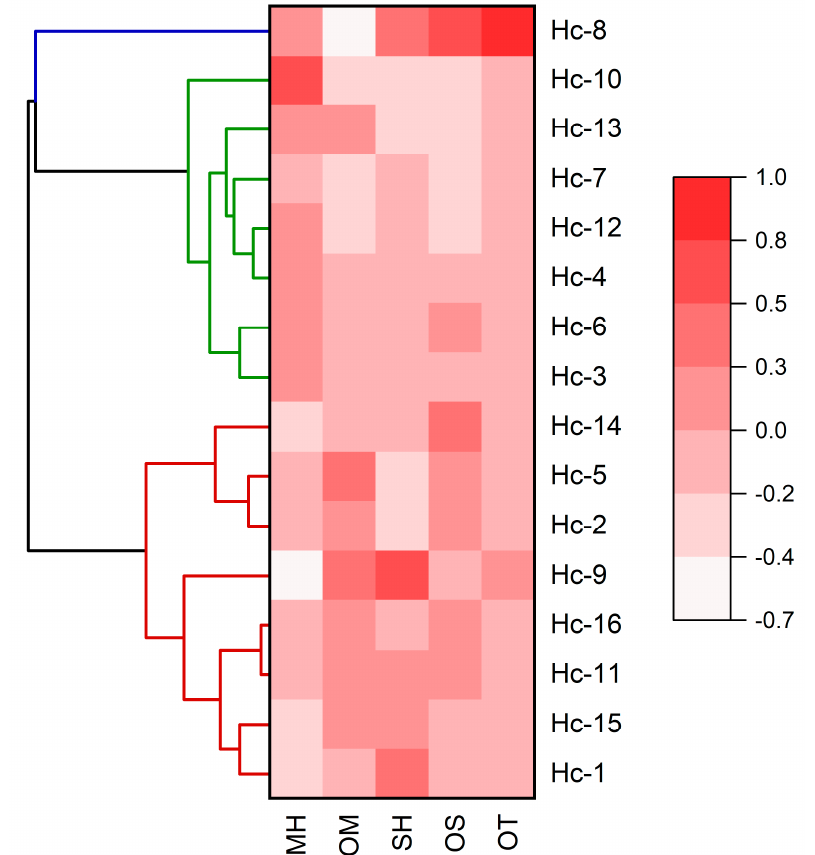
Figure 5. Clustered heat map of the volatile classes of Hyptis crenata samples.